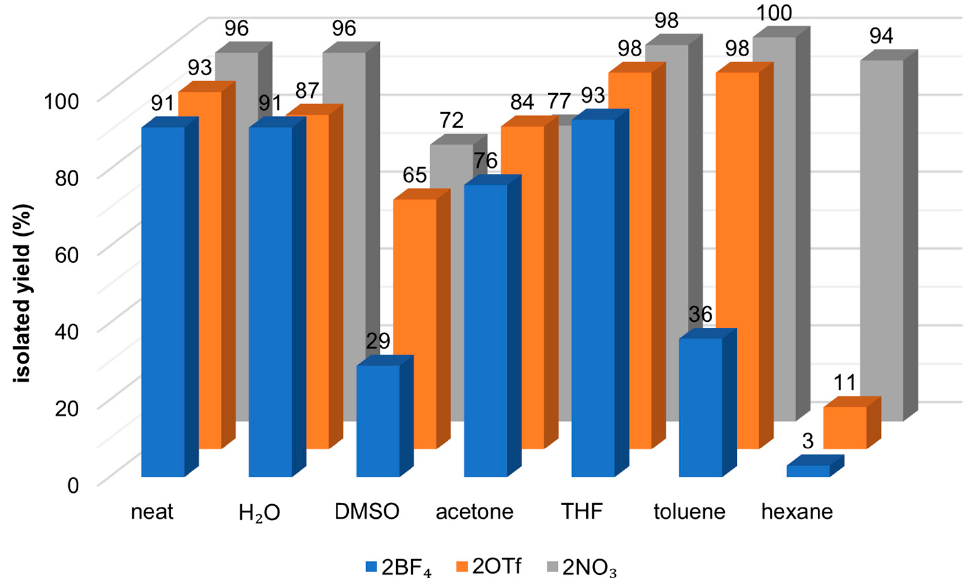
Figure 3. Representation of isolated yields of 1-benzyl-4-phenyl-1,2,3-triazole in different solvents (1 mL) utilizing complexes 2 X as catalysts. Isolated yields are the average of at least two independent runs.